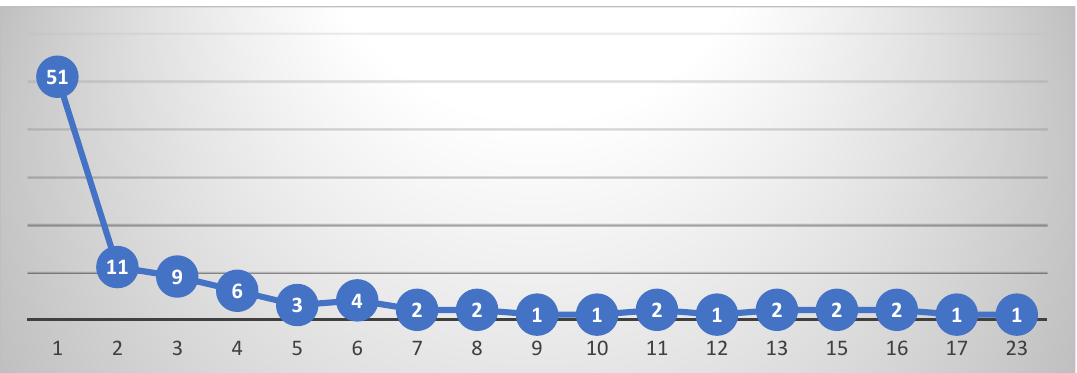
Figure 3. Distribution of church school attendance April 2017 to December 2018 (n = 102).